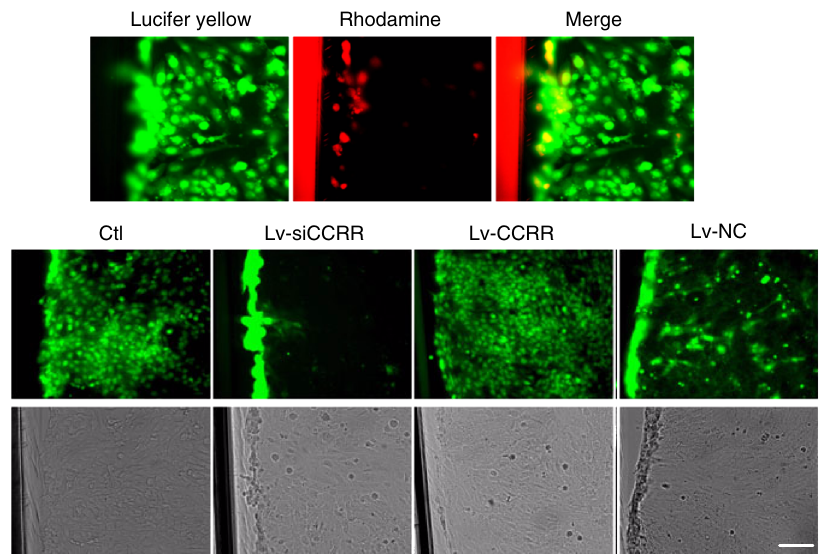
Fig. 6 CCRR improves gap junction communication in AC16 human heart cells. AC16 human adult ventricular cardiomyocytes were loaded with a diffusible fl uorescent dye (Lucifer yellow), and the diffusion of the dye was monitored under a laser confocal microscope (200× magni fi cation). Note that CCRR overexpression after infection of Lv-CCRR signi fi cantly promoted, whereas CCRR knockdown by Lv-siCCRR nearly completely blocked, the diffusion of Lucifer yellow among AC16 cells (green). The high molecular weight marker dye conjugate Rhodamine B was used as a negative control (red). Similar data were acquired from another three independent